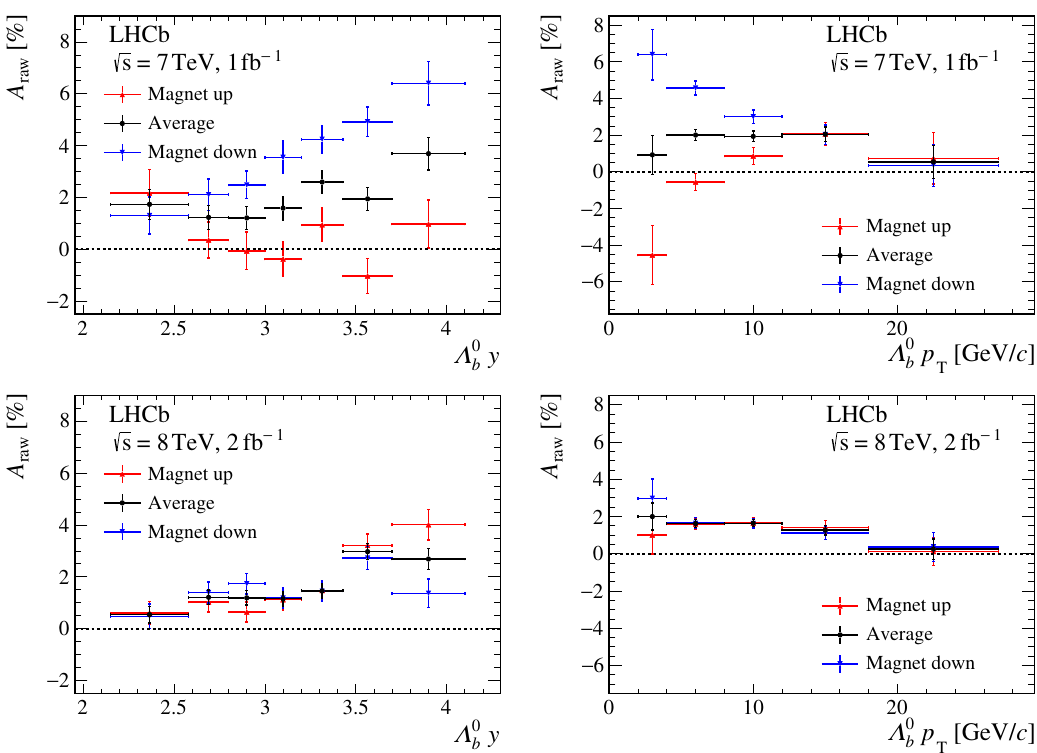
Figure 4 . Measured raw asymmetry versus (left) rapidity and (right) p T for (cid:3) 0 data taken at centre-of-mass energies of (top) p s = 7 TeV and (bottom) p s = 8 TeV. The results are shown separately for (red upward triangles) magnet up, (blue downward triangles) magnet down and (black dots) their average. Uncertainties are statistical